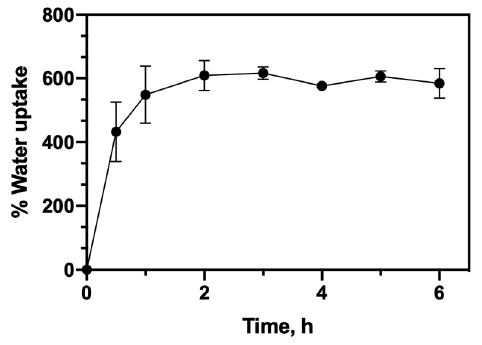
Figure 3. Water uptake profile of CHT/PCD sponge in PBS (pH 7.4) at 37 °C and 80 rpm. The test was carried out at least twice and each in triplicate ( n = 6).